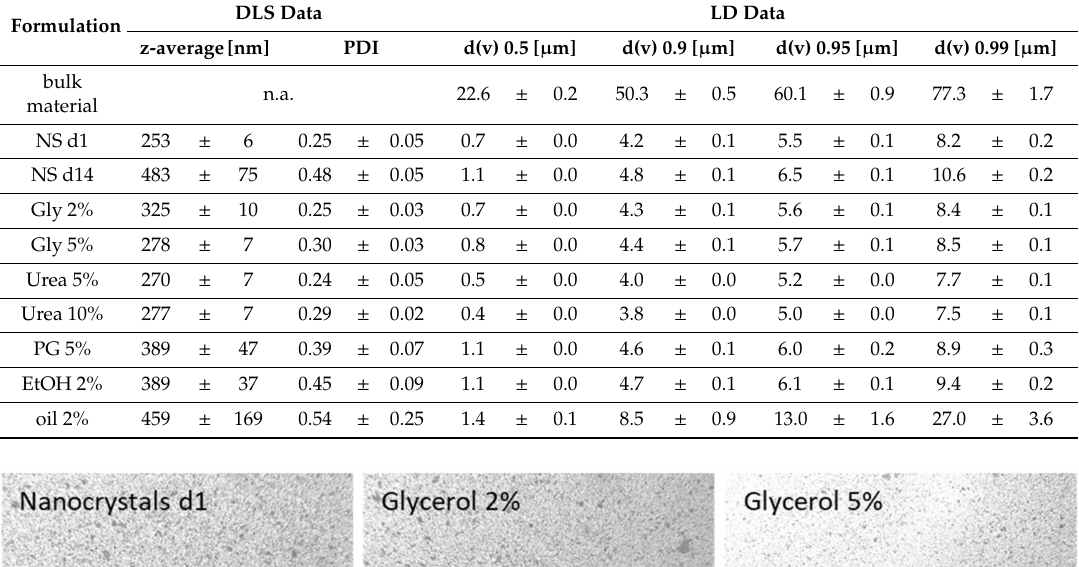
Table 2. Particle sizes and size distributions (DLS data and LD data) for the curcumin bulk material, the nanosuspension without excipients and for the nanosuspensions after the addition of di ff erent excipients.